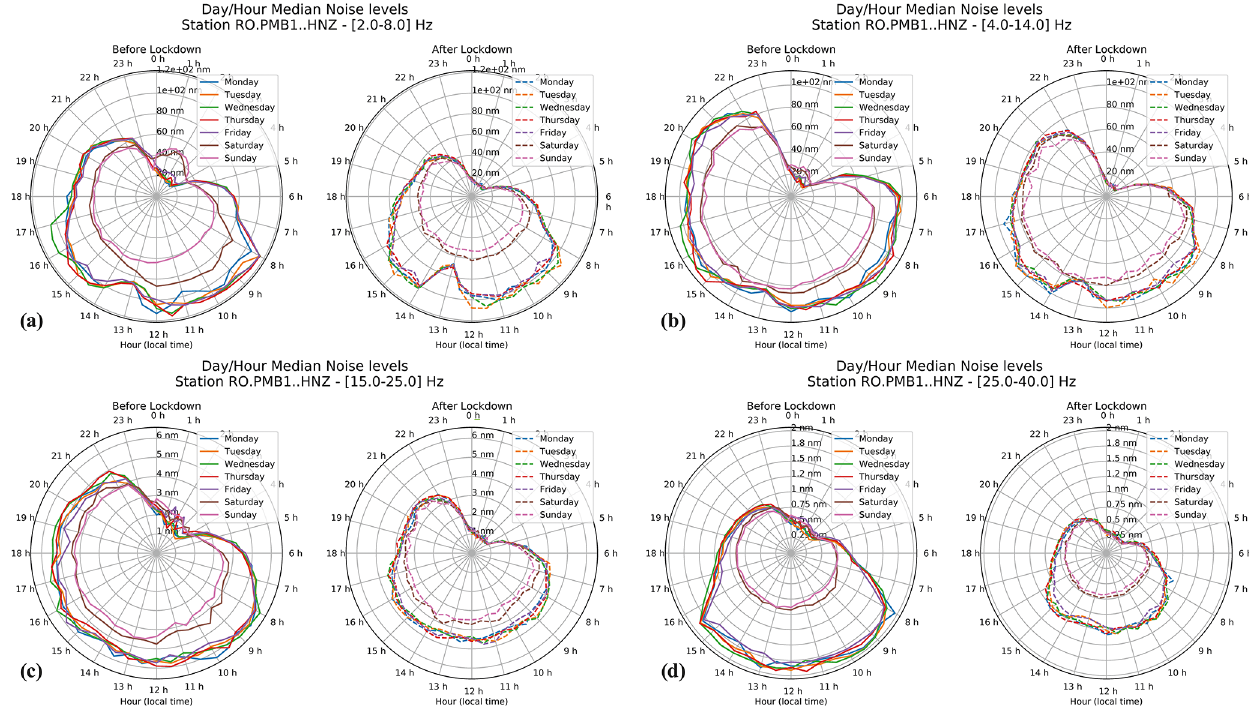
Figure 9. Lockdown effects shown on 24h clock plots at the station PMB1 located in the Bucharest City Hall building (ground floor) for the frequency bands 2–8Hz (a) , 4–14Hz (b) , 15–25Hz (c) , and 25–40Hz ( d )(see Fig. 1 for the station